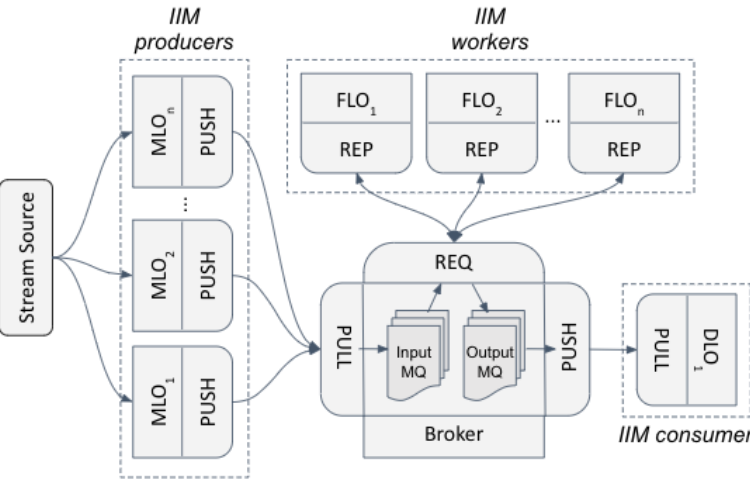
Figure 6. Workload distribution with load balance on worker (FLO)